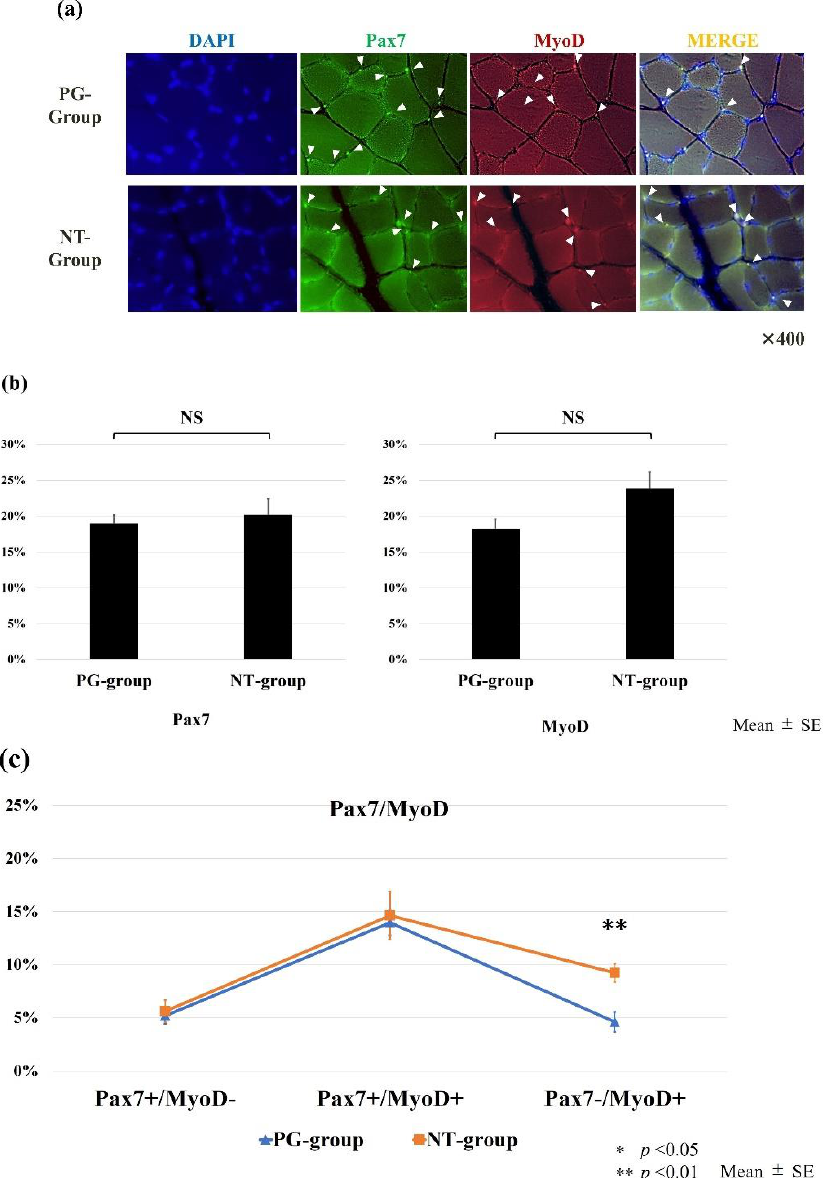
Figure 4. ( a ) Expression of Pax7 and MyoD; ( b ) the rates of Pax7- and MyoD-positive cells; ( c ) the results of Pax7/MyoD double staining. The Pax7−/MyoD+ cell was significantly larger in the PG group than in the NT group.